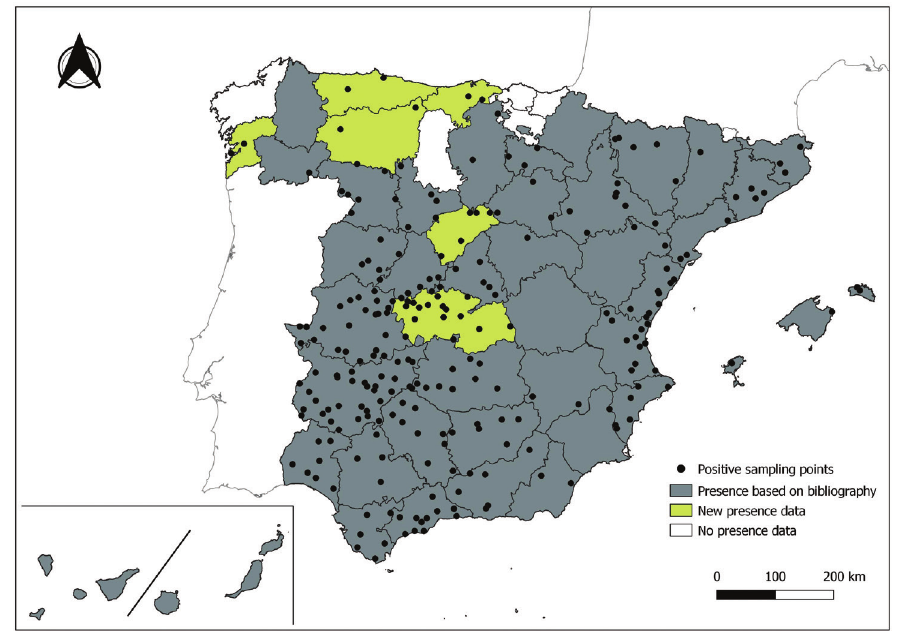
Figure 7. Distribution of Sergentomyia minuta in Spain.